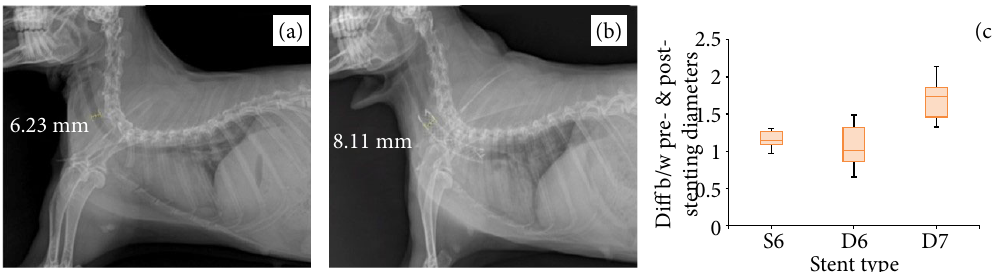
Figure 6 - Lateral radiographic views of the trachea in a rabbit model before and after stenting. (a) The pre-stenting diameter of the normal cervical trachea. (b) The post-stenting (D-type with a wire diameter of 0.007 inches) diameter of the cervical trachea. (c) Boxplot of differences between the pre- and post-stenting diameters (mm) for groups A, B, and C. The difference was the greatest in group C (p<0.05).